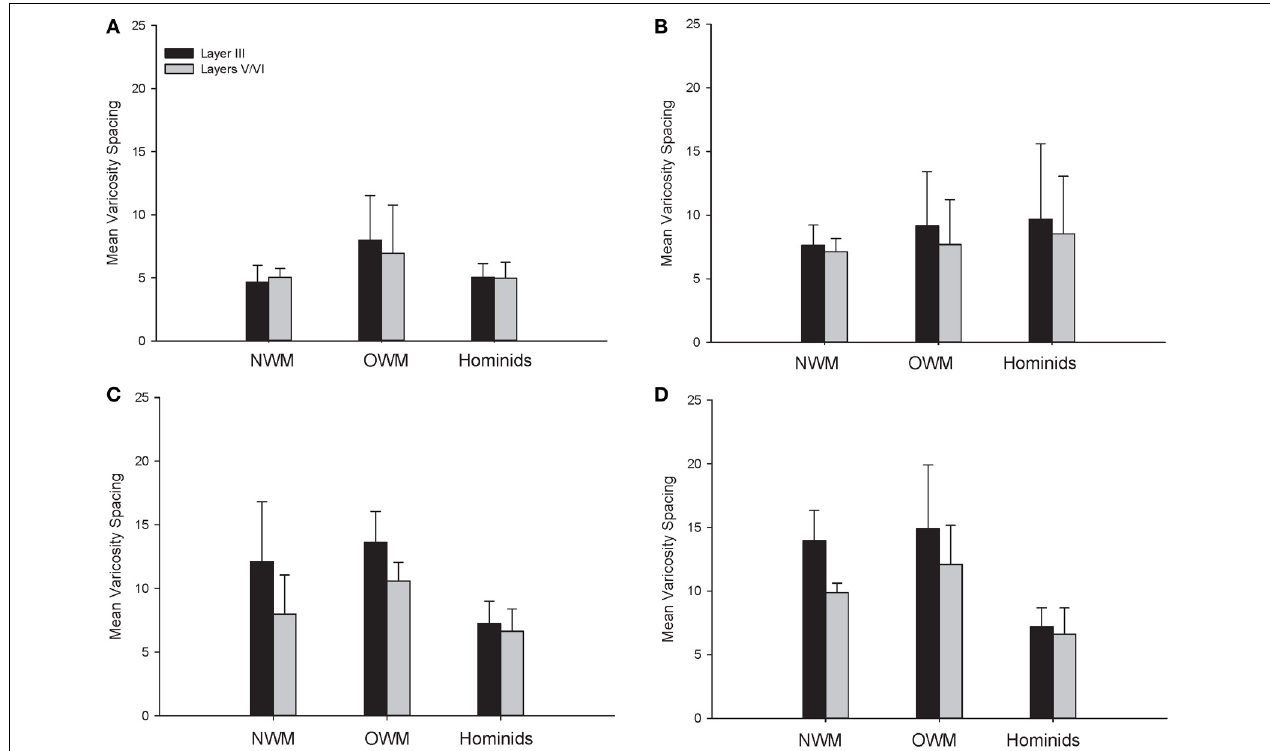
FIGURE 10 | NPY-ir varicosity spacing collapsed into phylogenetic groups for (A) area 10, (B) area 24, (C) area 44, and (D) area 22. OWM, Old World monkeys; NWM, New World monkeys. Means are shown by bars. Error bars indicate standard deviation.